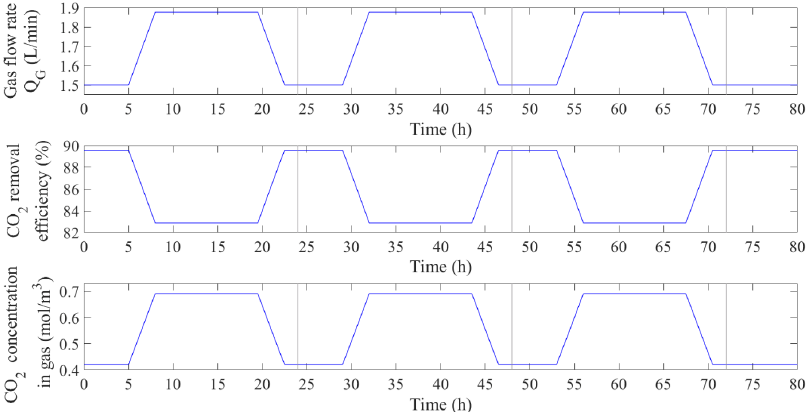
Figure 16. Gas flow variation scenario and the system ’ s response to the variation in time.